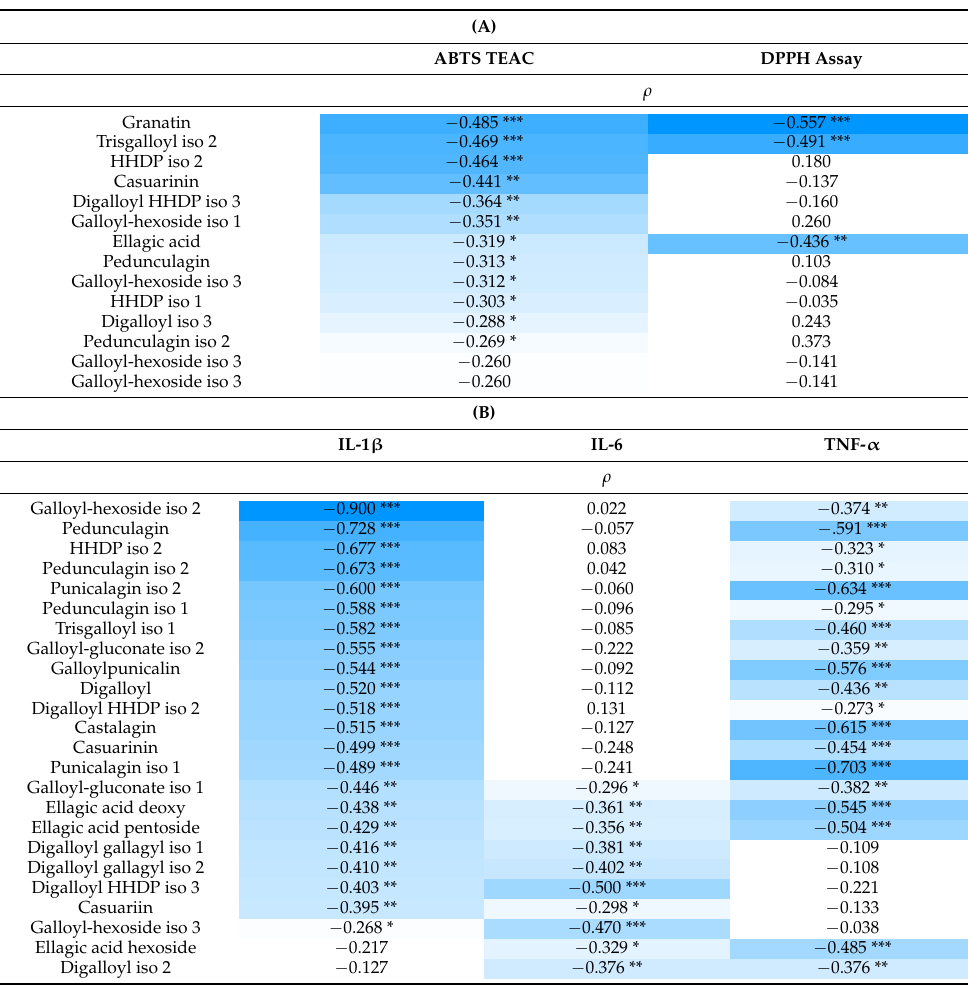
Table 5. Pearson correlation coefficients ( ρ s) between metabolites and ( A ) antioxidants and ( B ) anti-inflammatory activities of pomegranate peel extracts. Only negative statistically signifi- cant correlations ( p ≤ 0.260; *: p ≤ 0.05; **: 0.01 ≤ p ≤ 0.05; ***: p ≤ 0.001) were reported. Blue color intensity is directly proportional to Pearson coefficient